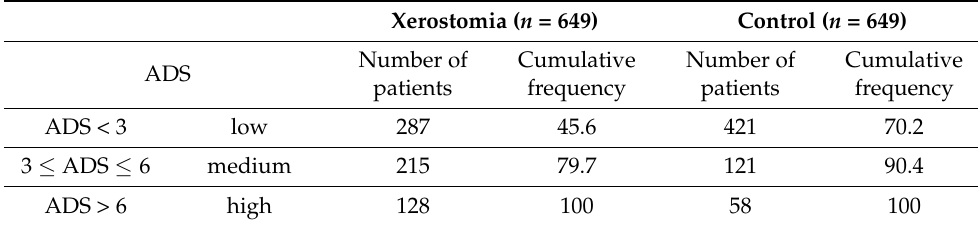
Table 2. Prevalence of low, medium, and high anticholinergic drug scores (ADS).